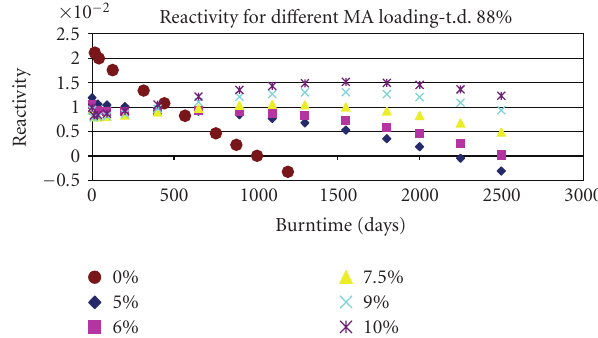
Figure 2: The reactivity for di ff erent MA loadings. The reactivity swing decreases for increased MA loading. For an MA loading above 6%, the reactivity increases during the